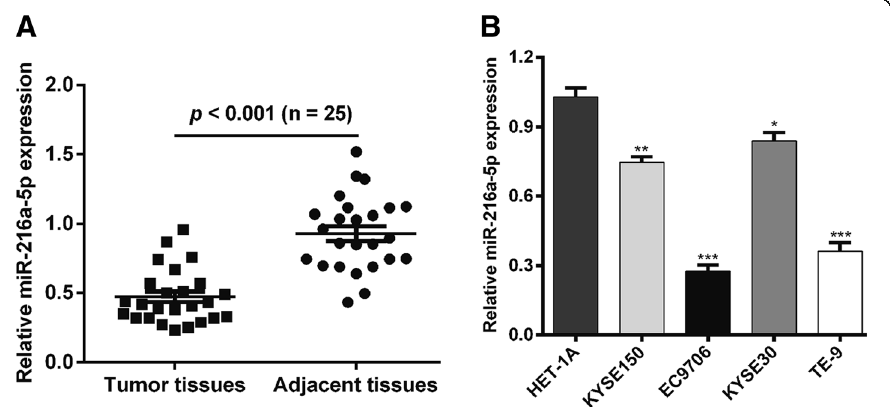
Fig. 1 MiR-216a-5p was significantly down-regulated in ESCC tissues and cell lines. a MiR-216a-5p expression levels in 25 pairs of ESCC tissues compared with matched adjacent normal tissues were determined using qRT-PCR. b MiR-216a-5p expression in four ESCC cell lines and normal esophageal epithelial HET-1A cells was measured using qRT-PCR. * p < 0.05, ** p < 0.01, *** p < 0.001 vs. normal group; ESCC, esophageal squamous cell carcinoma; qRT-PCR, quantitative real-time